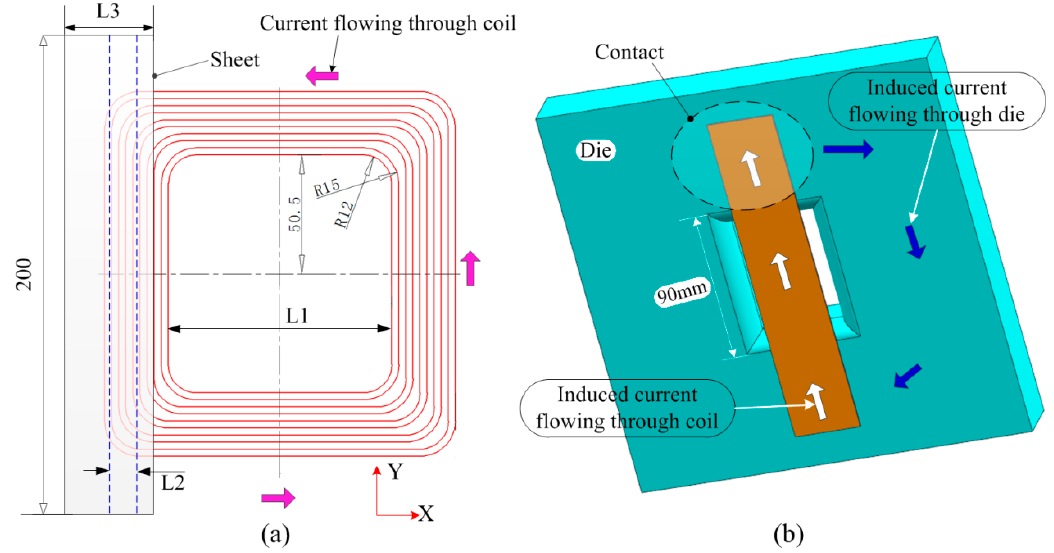
Figure 2. Design principle for the new uniform-pressure coil. ( a ) Coil and sheet and ( b ) induced current flowing in the sheet and die.